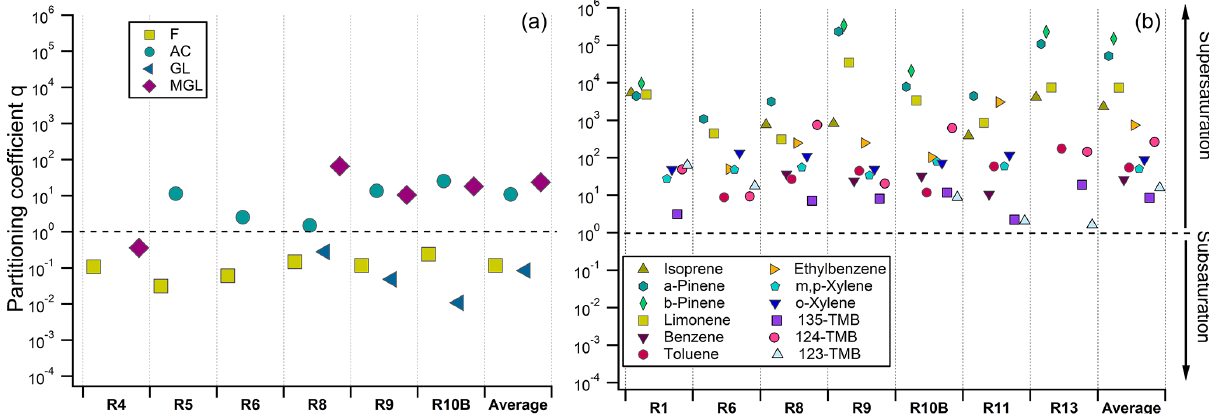
Figure 8. Partitioning coefficient q factors calculated for individual cloud samples and individual OVOCs (a) and low-solubility VOCs (b) , considering the average temperature and LWC measured during the sampling of each cloud event. Average corresponds to the average q factors for the cloud events. Partition coefficients are calculated when measurements in both the aqueous and gas phases were available and validated. R1 to R13 refer to individual cloud samples. More details about the samples can be found in Tables S1 and S6.